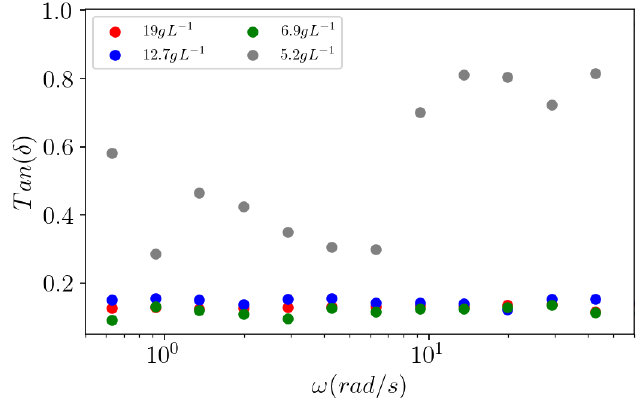
Figure 13. Tan δ = G”/G (cid:48) as a function of the pulsation at applied strain γ = 0.1 for APP-E pectins with effective concentrations from 5.2 g L − 1 to 19 g L − 1